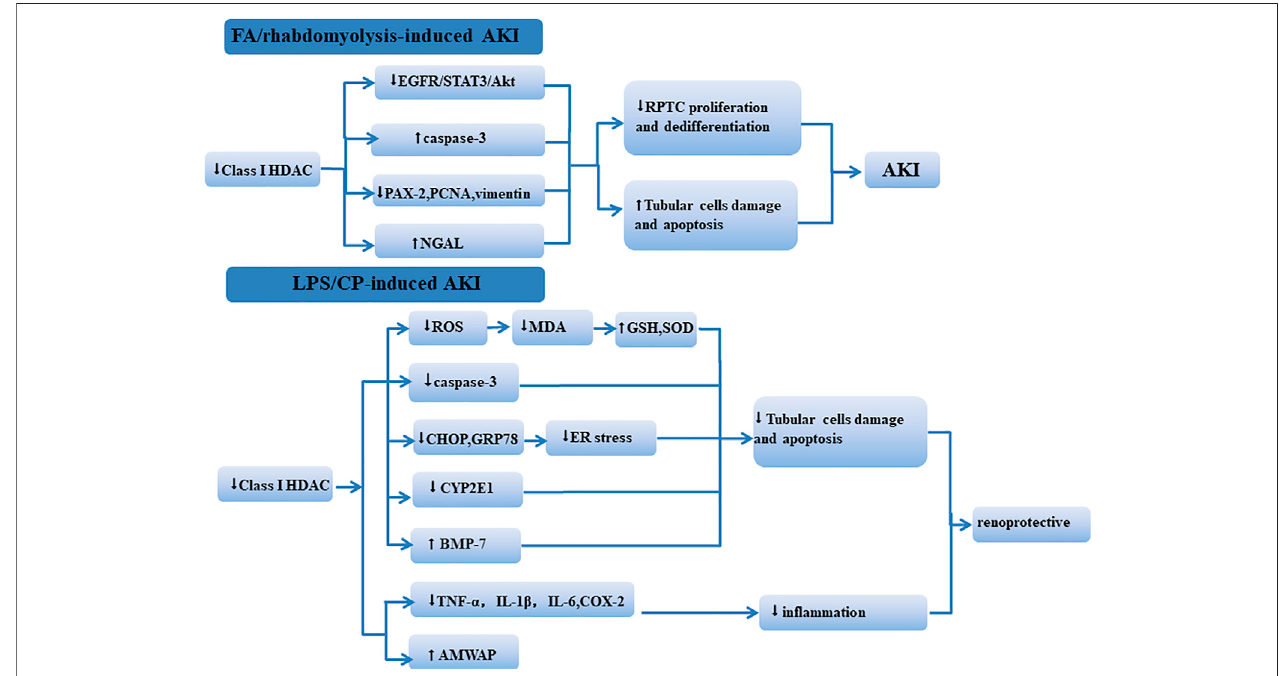
FIGURE 1 | Mechanism of class I HDACs in fl uencing the kidney in different AKI models. In FA/rhabdomyolysis-induced AKI, class I HDACs participate in renal protection by regulating the EGFR/STAT3/AKt signaling pathway and reducing tubular cell apoptosis. In LPS/CP-induced AKI, the inhibition of class I HDACs reduced kidney damage through regulating oxidative stress, apoptosis, and in fl